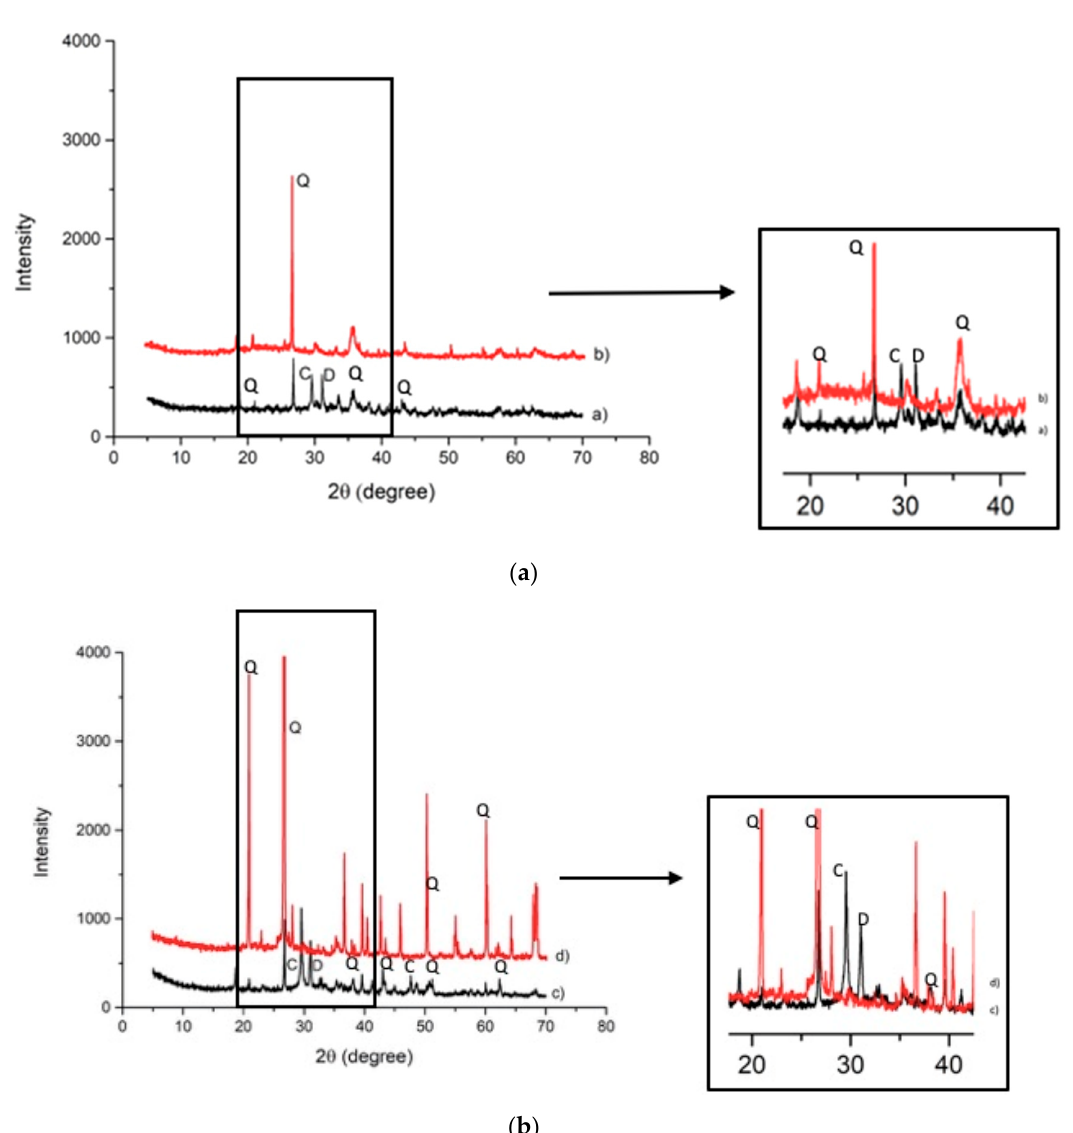
Figure 10. ( a ) XRD pattern of A50NW AAM a), A50NW AAM after HCl test b) (C = calcite, D = dolomite, Q = quartz). ( b ) XRD pattern of R50NW AAM c), R50NW AAM after HCl test d) (C = calcite, D = dolomite, Q = quartz).